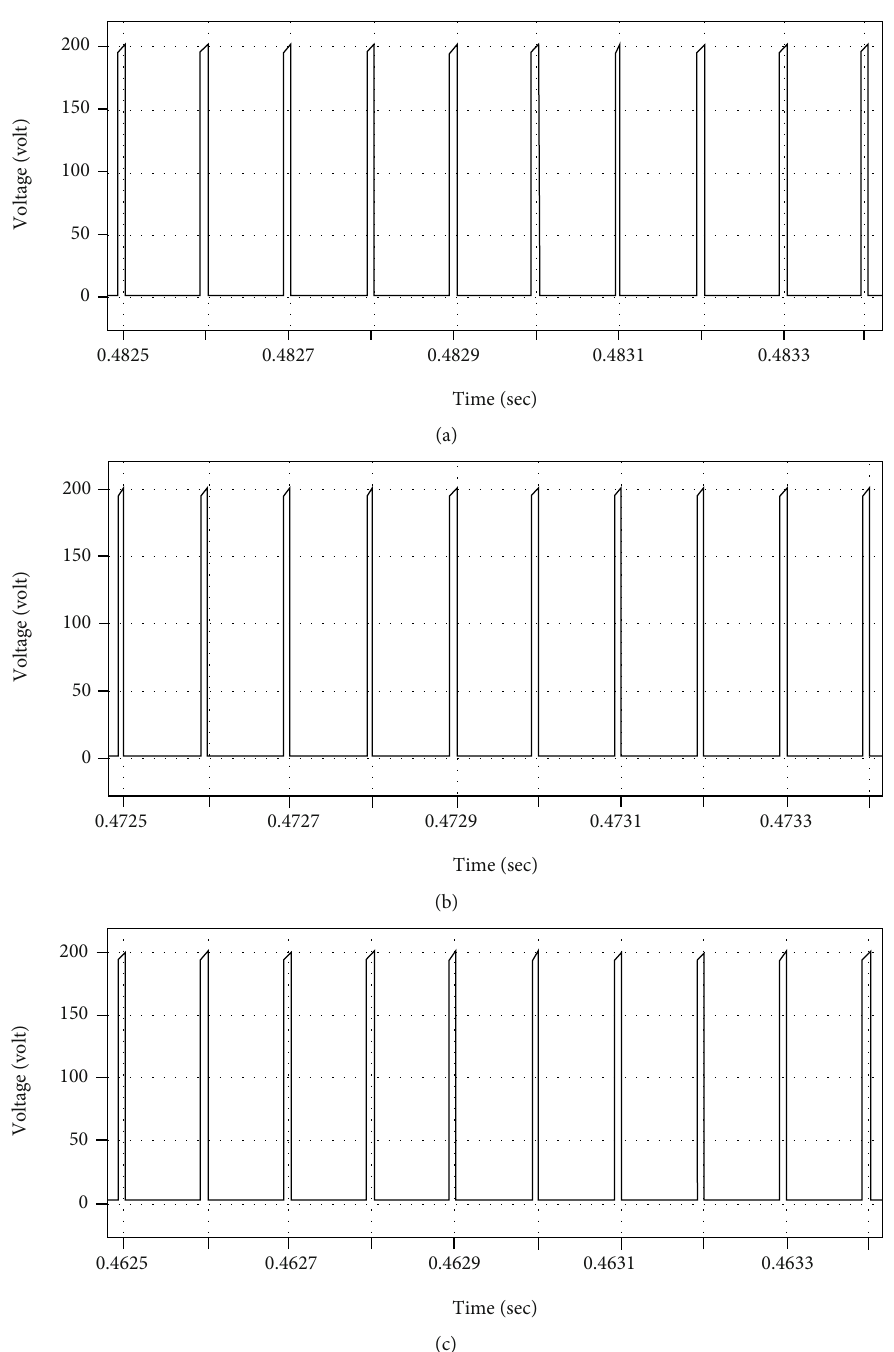
Figure 13: (a) Voltage stress across MOSFET M